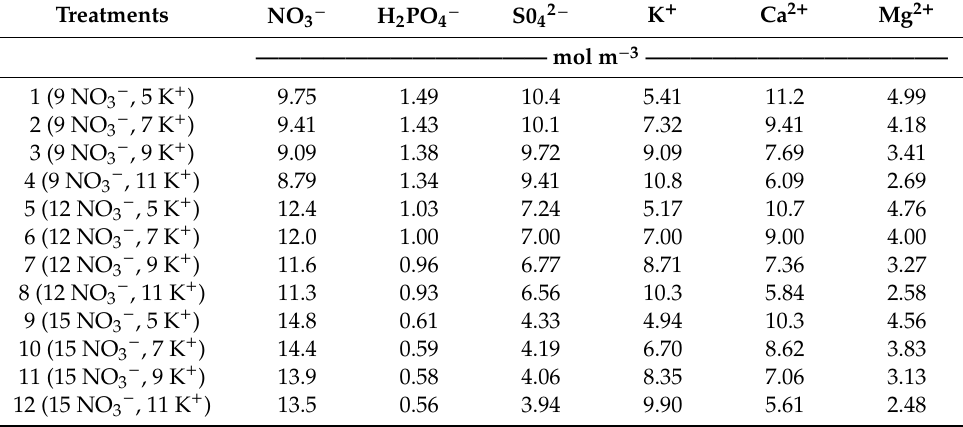
Table 3. Nutritional composition of the solution with the treatments applied in the cultivation of strawberries under soilless conditions. Treatments NO 3